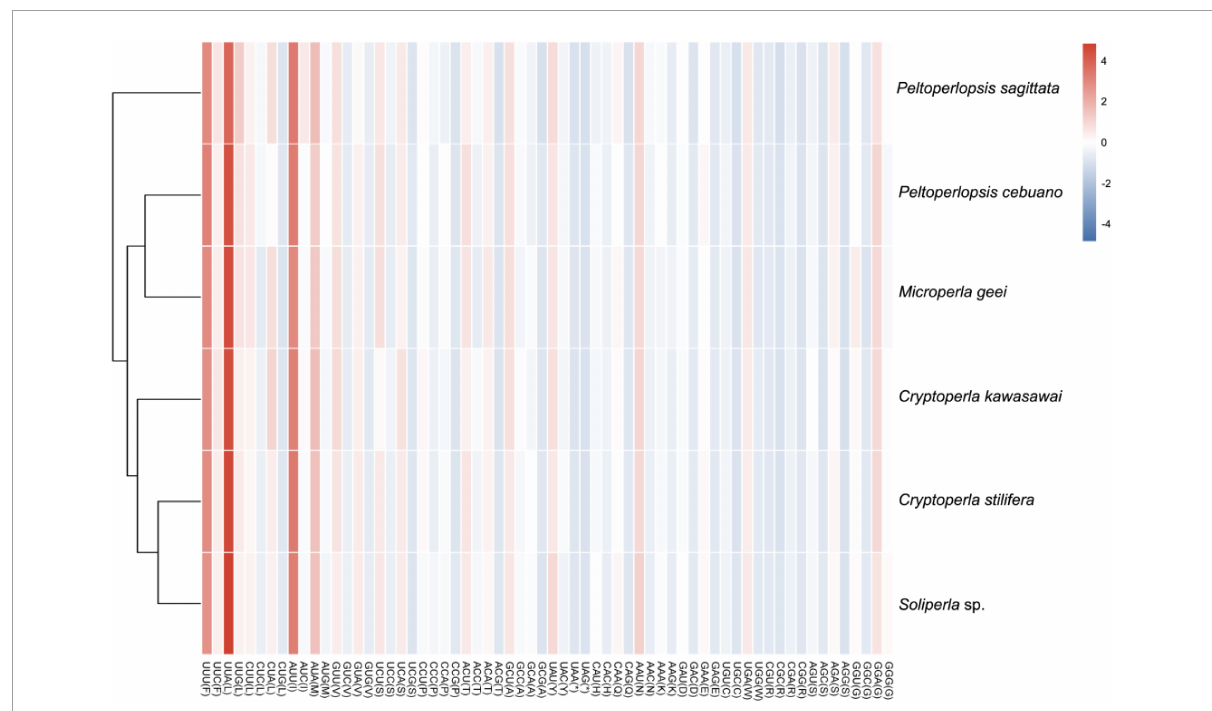
FIGURE3 Heatmap of codon usage for protein-coding genes in Peltoperlidae. Red and blue in the heatmap indicate high and low absolute correlation, respectively. The species in the rows of the heat map are sorted by the corresponding cluster tree based on codon usage. The columns indicate 64 codons of the invertebrate mitochondrion.